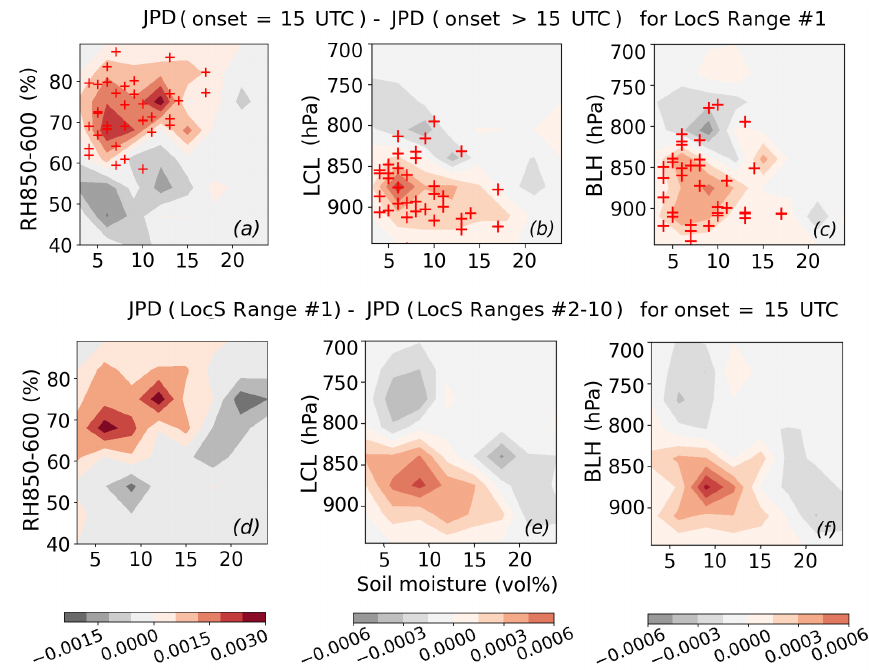
Figure 6. Preference of early onset AR events to occur over particular antecedent soil moisture and boundary layer conditions. ( a – c ) Difference in the Joint Probability Distribution (JPD) of absolute soil moisture (at 13:30 LST) and each boundary layer variable (at 12 LST) between AR events with an earlier onset time (i.e., 15 LST) and a later onset time (i.e., 18–24 LST). The plots refer to the events occurring over extreme heterogeneous and dry soils ( LocS Range #1) only. Accordingly, red shading indicates a higher probability of early onset AR events to occur over dry soil and moist boundary layer conditions as compared to AR events with later onset time (and vice versa for gray shading). ( d – f ) Difference in the JPD of absolute soil moisture (at 13:30 LST) and each boundary layer variable (at 12 LST) between early AR events that fall over extremely heterogeneous landscapes (Range #1) and those that fall in less heterogeneous states (Ranges #2–10). Accordingly, red shading indicates a higher probability of early onset AR events from the LocS Range #1 to occur over dry soil and moist boundary layer conditions as compared to early onset AR events from Ranges # 2–10. All plots show the mean relationship over the five small domains illustrated in Figure 1a. Red crosses place the lowest 10th percentile (i.e., the strongest) negative soil moisture gradients from all five domains in the corresponding parameter space. The selected boundary layer parameters from left to right are: Relative Humidity (RH, %) (averaged between 850 and 600 hPa), Lifting Condensation Level (LCL, hPa) and Boundary Layer Height (BLH,